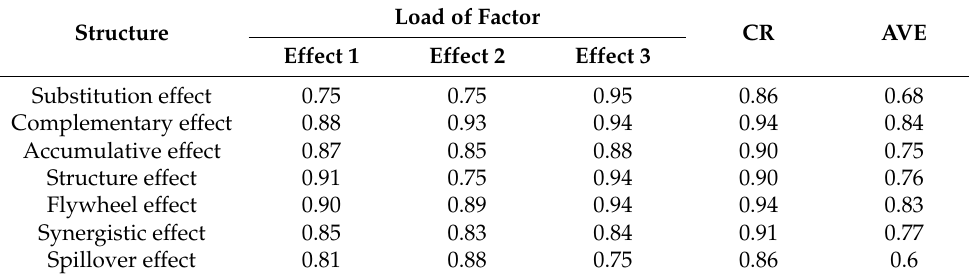
Table 2. Reliability and convergent validity.